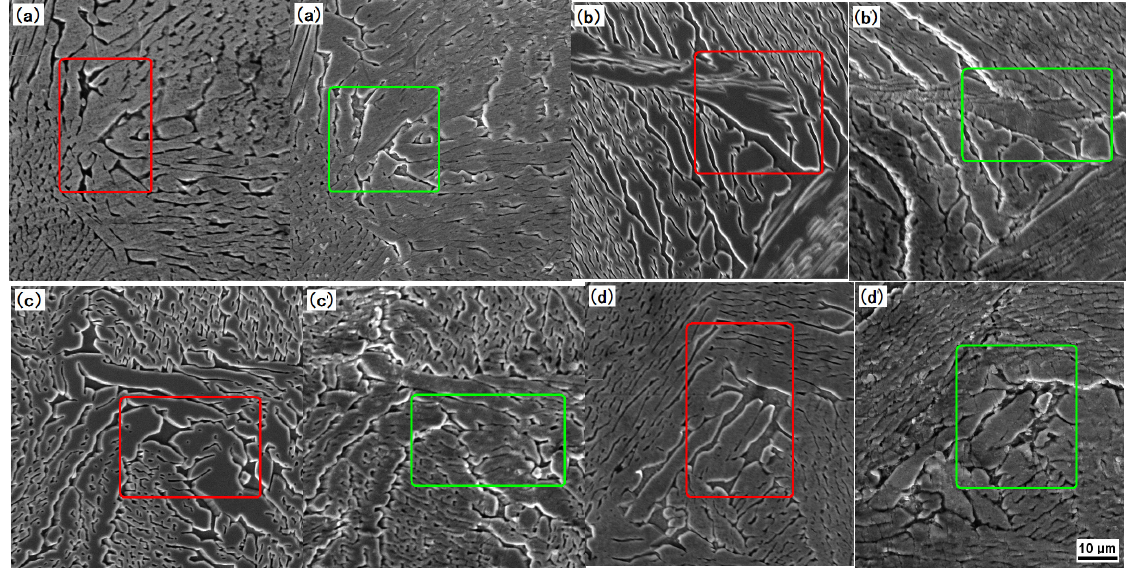
Figure 8. Effect of deformation strain on flow under 400 °C and 500 °C: ( a ) 400 °C, strain of 25% before upsetting, ( a’ ) 400 °C, strain 25% after upsetting, ( b ) 400 °C, strain of 35% before upsetting, ( b’ ) 400 °C, strain of 35% after upsetting, ( c ) 500 °C, strain of 25% before upsetting, ( c’ ) 500 °C, strain of 25% after upsetting, ( d ) 500 °C, strain of 35% before upsetting, ( d’ ) 500 °C, strain of 35% after upsetting (The red rectangles are the observation areas before deformation and the green rectangles are the observation areas after deformation).